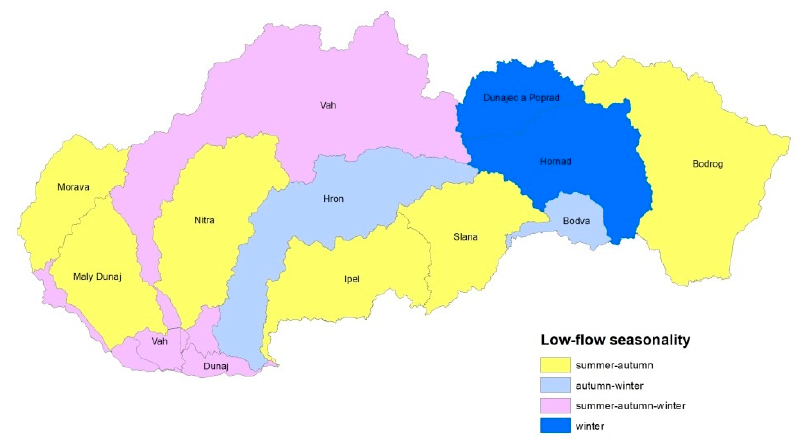
Figure 11. Sub-catchments in Slovakia according to the prevailing seasonality of the five longest low-flow episodes; 1961–2015, limit Q 355d .